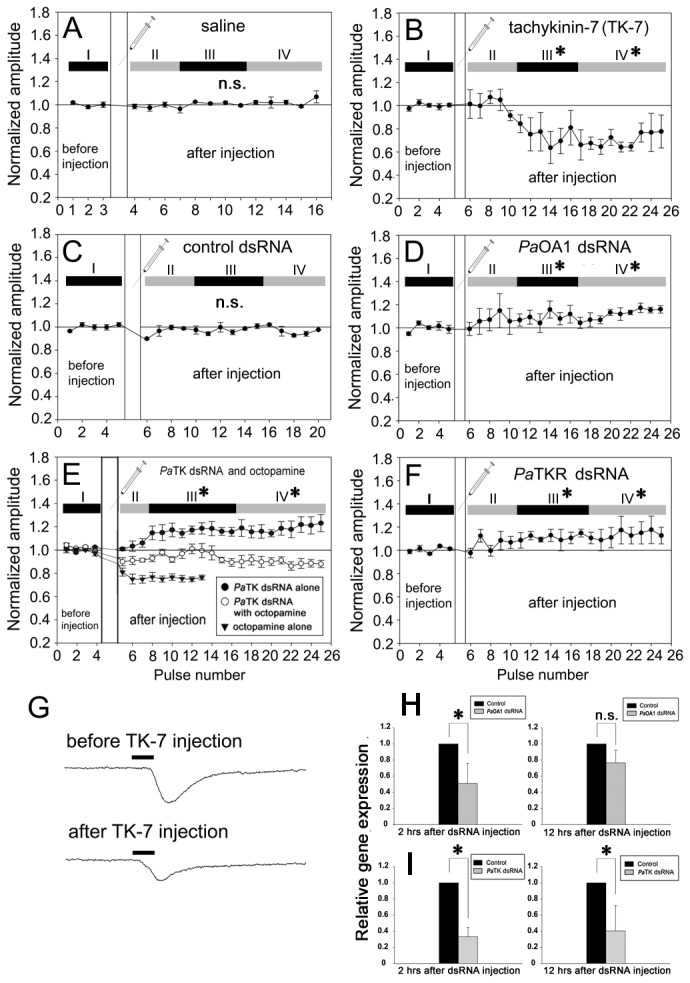
Effects of “before and after injection” of tachykinin, octopamine receptors, tachykinin receptors on olfactory responses (EAG) in antennae and quantitative real-time PCR after dsRNA injection of tachykinin and octopamine receptor.(A) There was no significant difference before and after a control injection of saline (N=3, p>0.6). (B) Tachykinin-7 (TK-7) injection produced a significant decrease in olfactory responses phase II and phase III after injection compared to before injection (phase I) (N=5, *=p<0.001). (C) Injection of control dsRNA from an expression vector (pQE30) did not significantly alter EAG responses (N=5, p>0.7). (D) Injection of octopamine receptor (PaOA1) dsRNA elicited significant increase in EAG amplitude in Phase III and IV, which continued to over 2 hours after injection (N=5, p<0.001). (E) Three EAG traces showed interaction between octopamine and tachykinin on the modulation of olfactory sensitivity in cockroach antennae. Injection of octopamine itself (inverted triangle) decreased EAG response after injection in Phase III and IV, while TK-dsRNA (filled circle) induced significant increase of EAG amplitude (N=5, p<0.01). Notably, the enhanced effect of TK-dsRNA on EAG responses was eliminated when co-injected with octopamine (empty circle). (F) Injection of tachykinin receptor (PaTKR) dsRNA had a significant positive effect on EAG amplitude (N=3, p<0.001). (G) Representative EAG traces before and after TK-7 injection, showing that TK-7 decreased EAG responses. (H) Relative RNA expression levels of octopamine receptor (PaOA1) in antennae after injection of octopamine receptor dsRNA were strongly reduced at 2 hours after injection but not significantly different 12 hours after injection (Student’s t-test: *, P≤0.05). (I) Relative RNA expression levels of tachykinin gene (PaTK) in antennae showed significant reduction at 2 and 12 hours after injection. Values depict mean ± SE. One-way ANOVA test followed by Bonferroni correction for multiple comparisons was employed to test the difference in EAG responses, while Student t-test was used to test the difference of gene expression levels. Pulse number indicates the number of ethyl acetate stimulation every five minutes. Phase I depicts EAG responses during “before injection” and phases II, III, and IV indicate EAG responses during “after injection”.